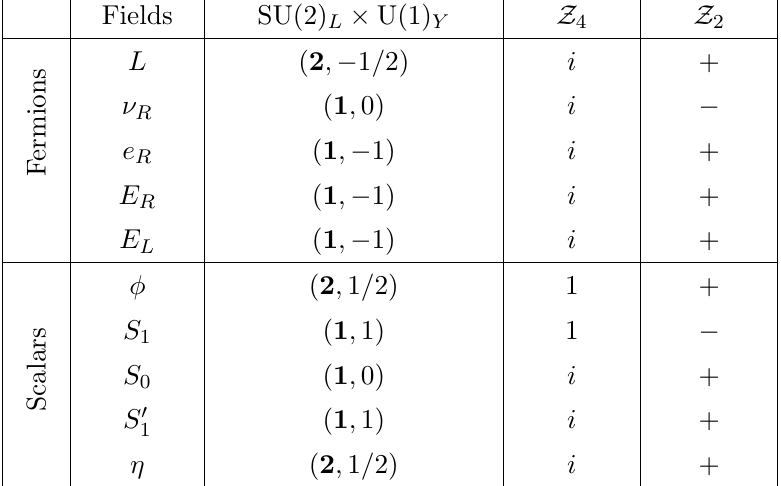
Z 4 (cid:2) Z 2 Z 4